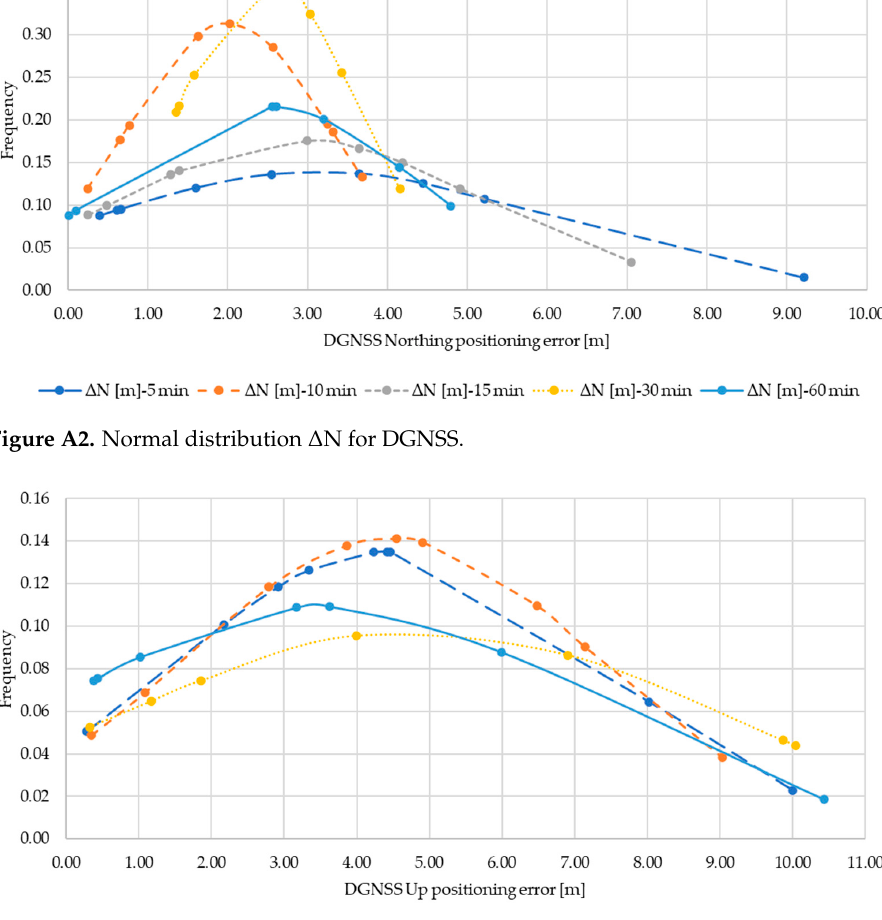
Figure A4. Normal distribution Δ E for SPP.